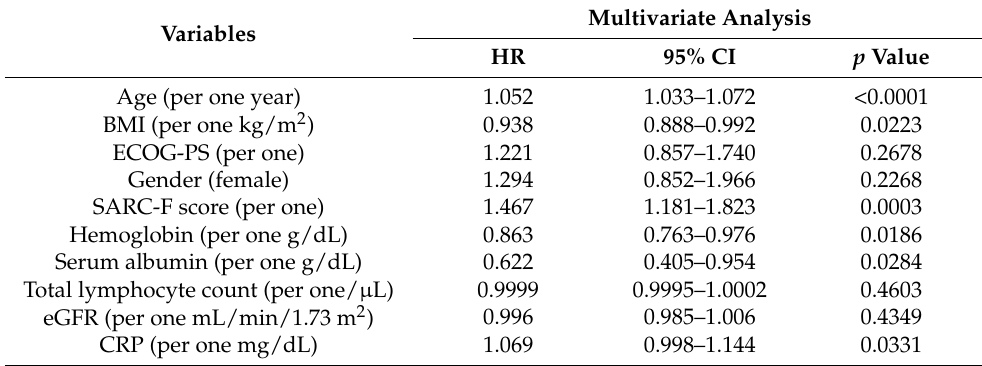
Table 3. Multivariate analysis of factors for the grip strength